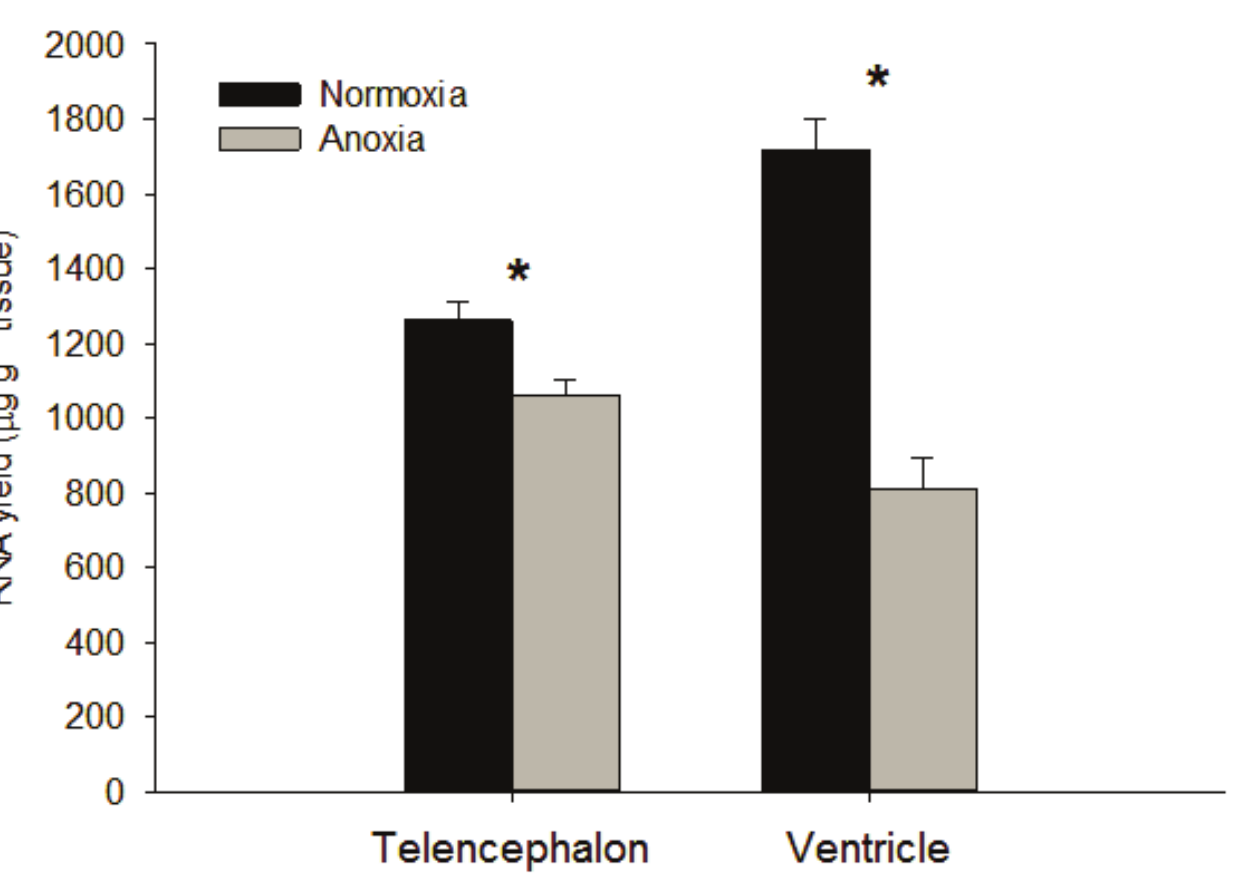
Fig 1. Effects of 24 hours of anoxia on tissue RNA content. After 24 hours of anoxia at 19°C, decreases in total tissue RNA occurred in both telencephalon and ventricle. * Indicates a significant difference between normoxia and anoxia within each tissue type. (Two-Way ANOVA, Tissue x Treatment df = 1, F = 28.303, P-value < 0.001; SNK post-hoc, control v. anoxic telencephalon, q = 3.013, P-value = 0.049; SNK post-hoc, control v. anoxic ventricle, q = 13.653, P-value < 0.001).